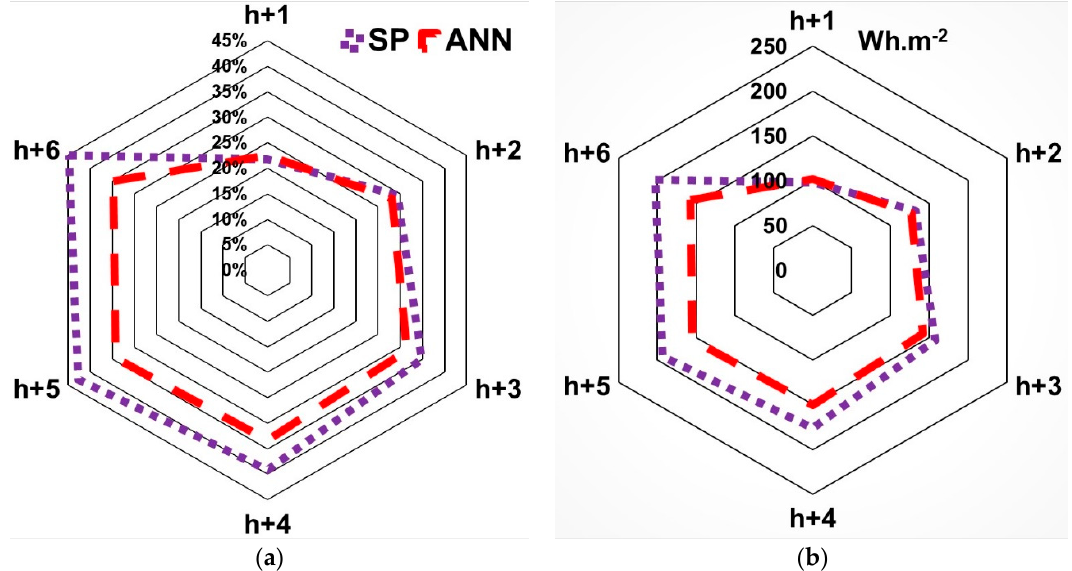
Figure 10. Comparison of forecasting models for various horizons for hourly GHI (Odeillo site); ( a ) in term of nRMSE; ( b ) in term of RMSE.